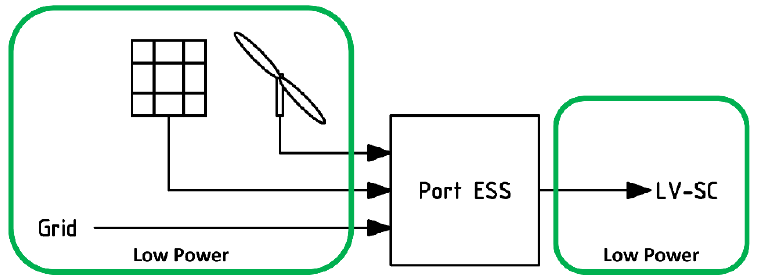
Figure 6. Integration among ESS, renewable sources, grid and LV-SC.